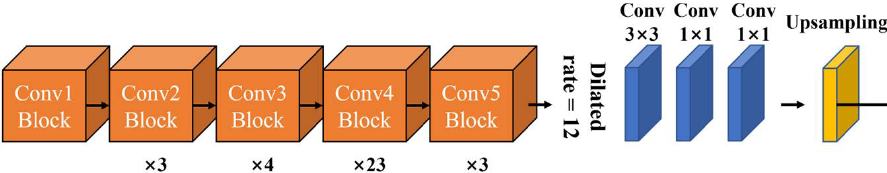
Figure 5. Structure of DeepLabv1 model.